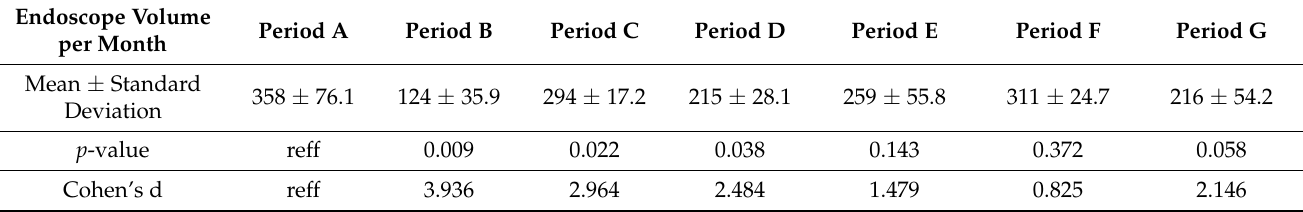
Table 1. Average Volume of Endoscopic Services in Periods A to G.